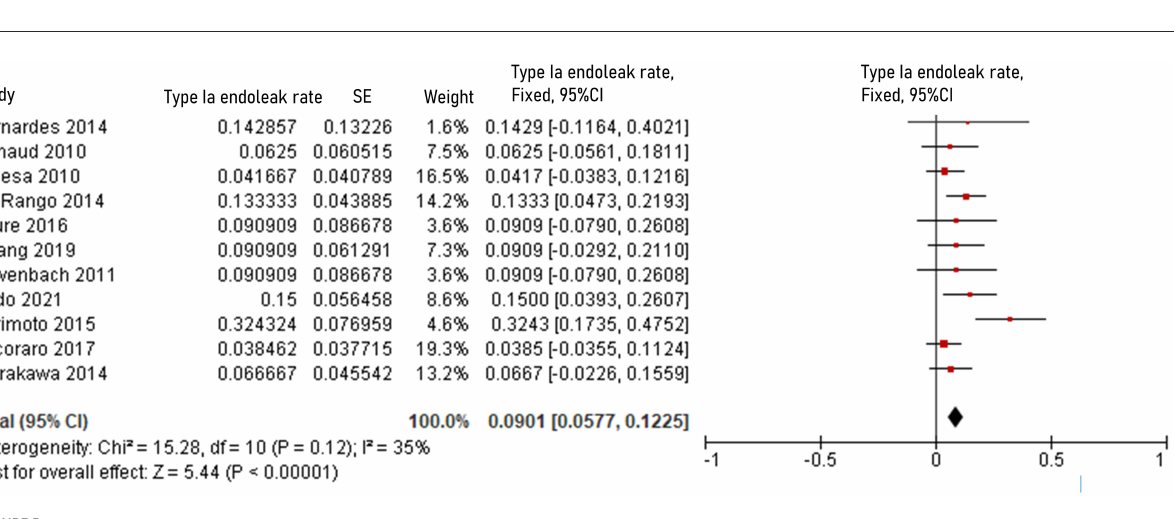
FIGURE5 Forest plot showing the fixed-effects proportion meta-analysis for type Ia endoleak rate. CI, confidence interval; SE, standard